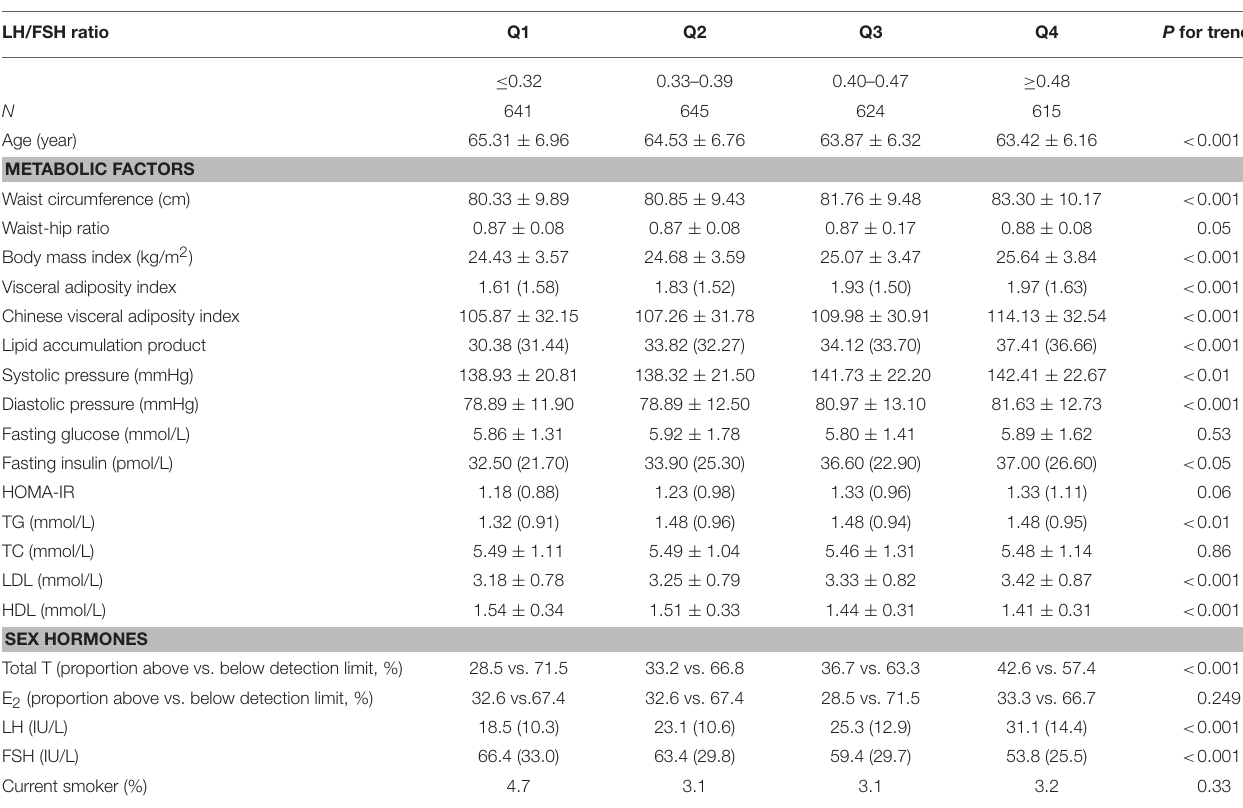
TABLE 2 | Characteristics of the subjects according to LH/FSH quartiles. LH/FSH